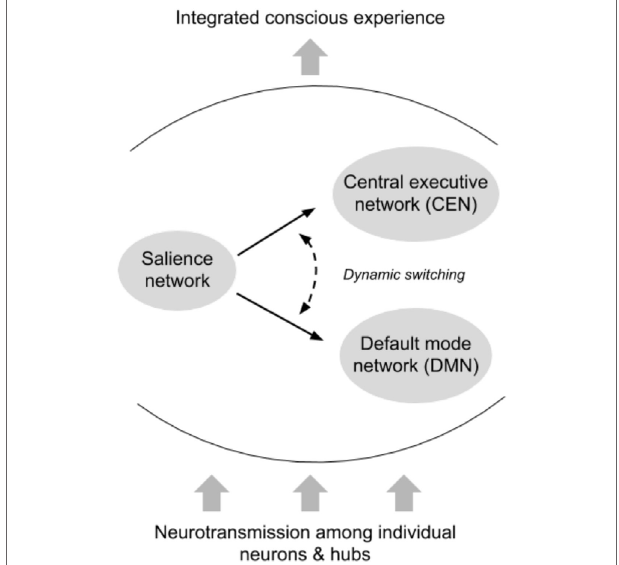
FigUre 2 | Interactions between intrinsic connectivity networks. The default-mode network (DMN) (64) is a highly coordinated network of hubs throughout the brain connected by long-range white matter tracts. The DMN is thought to be activated while an individual is at rest, and deactivated during goal-directed tasks (although there is some evidence that external tasks requiring social working memory may engage the DMN). In general, however, the DMN and other resting-state networks are deactivated once an individual begins task processing associated with external stimuli. Operating as a dynamic switch, the salience network deactivates the DMN and activates the central executive network, or vice versa . Successful switching between networks requires sensitivity to contextual demands, integration of multiple sources of information, and rapid appraisal, all of which are compromised with impaired or slowed neurotransmission. The dependence of such networks on long-range white matter tracts renders them particularly susceptible to the types of cellular insult observed in